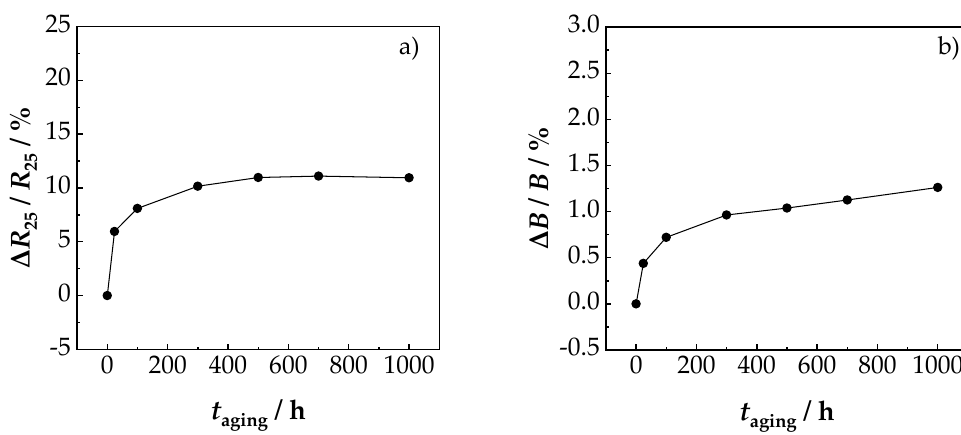
◦ C on ( a ) R 25 value and ( b ) B